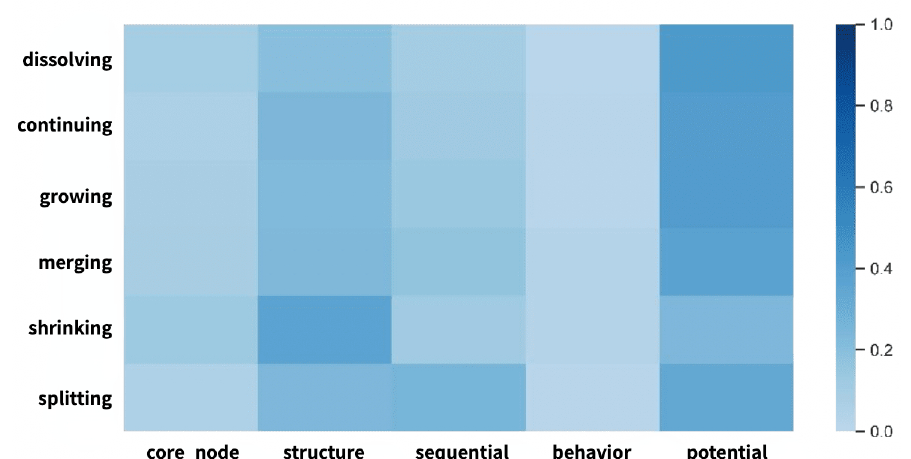
Figure 6. Distribution of importance of various features in the Enron data set.